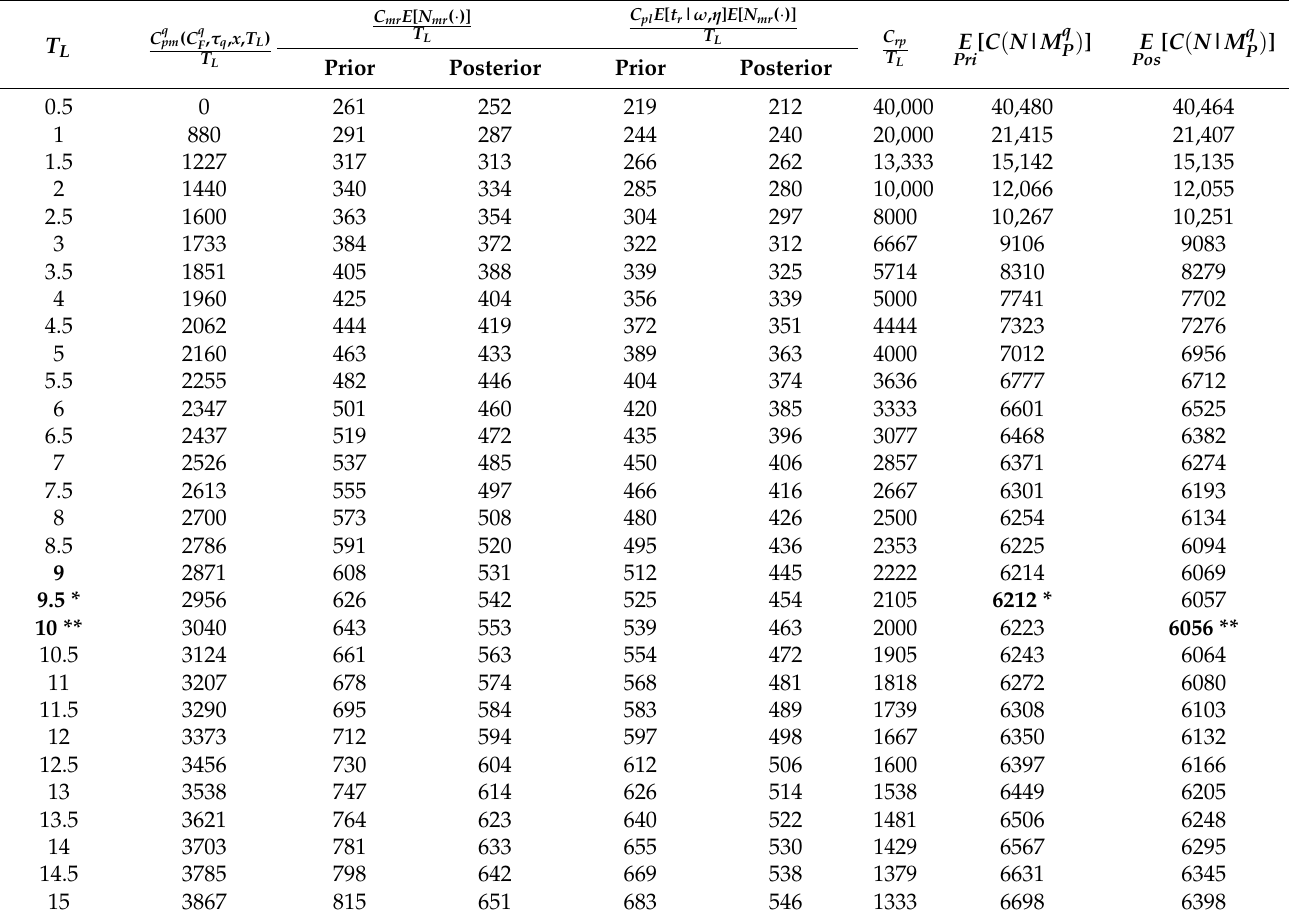
Table 4. The expected preventive cost, repair cost, penalty cost, replacement cost and overall cost per unit and year for PM Alternative for the prior and posterior